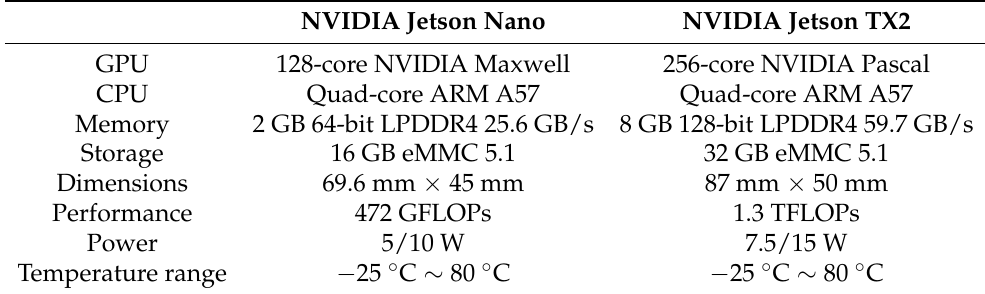
Table 2. Detailed hardware specifications of NVIDIA Jetson Nano and NVIDIA Jetson TX2 edge-